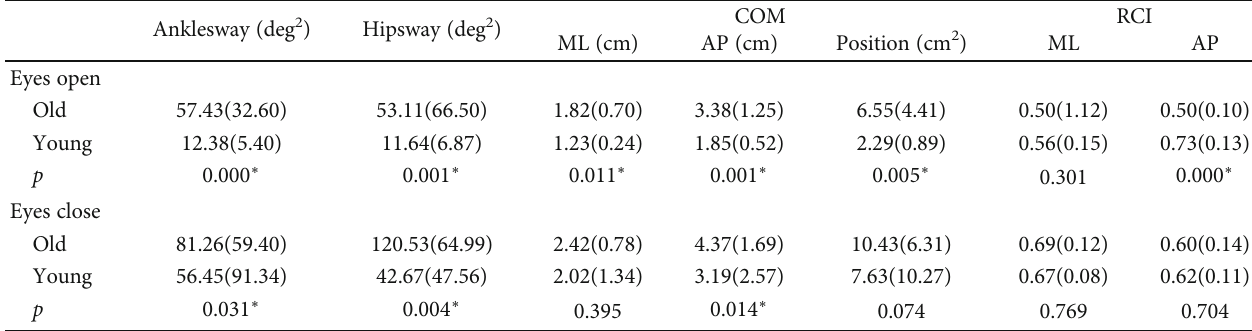
Table 5: Comparison of the values of sway between young and old healthy adults during one-leg standing with eyes-open and eye-closed